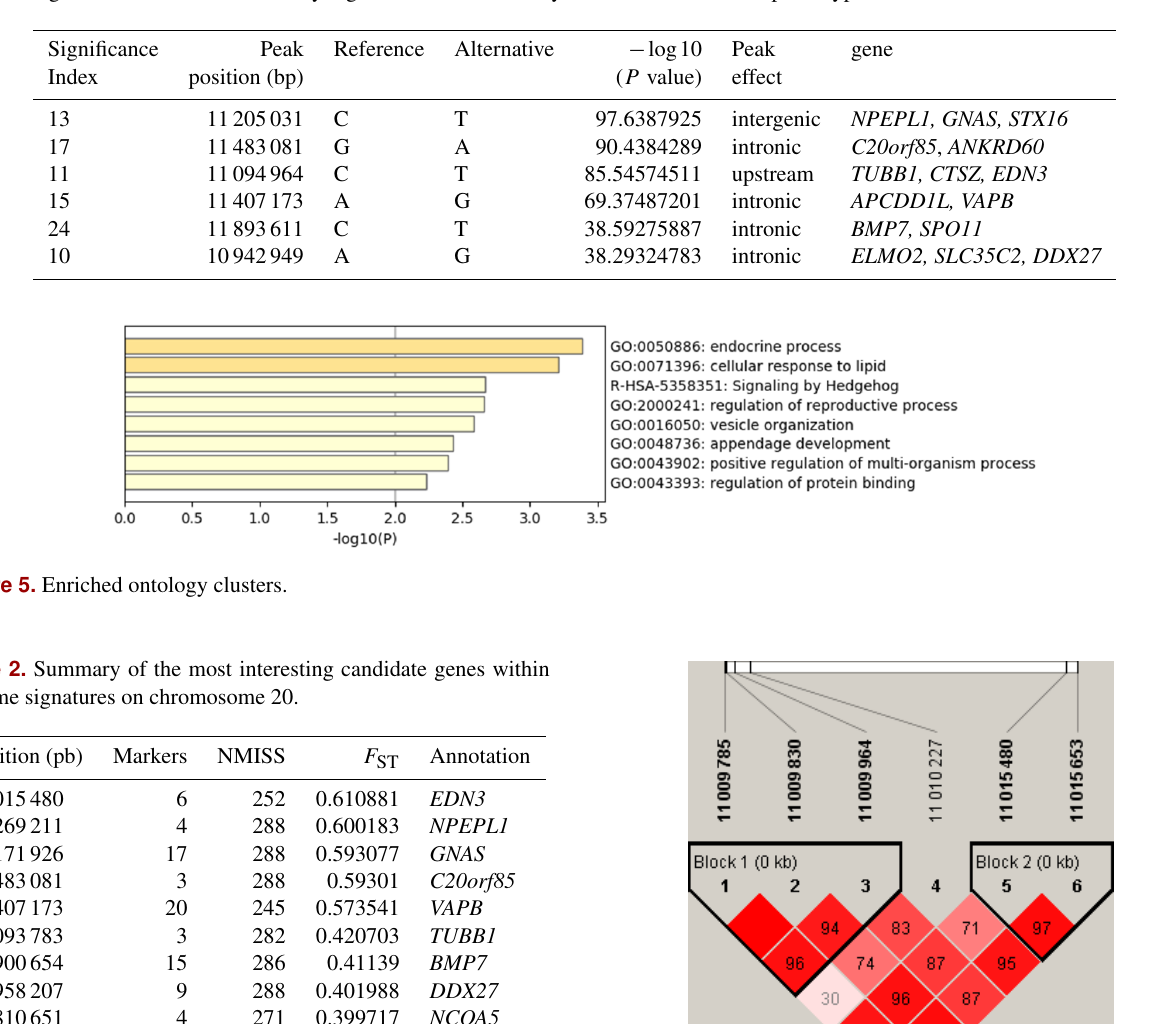
Table 1. Significant SNPs with extremely high P values revealed by a GWAS of face color phenotype on chromosome.